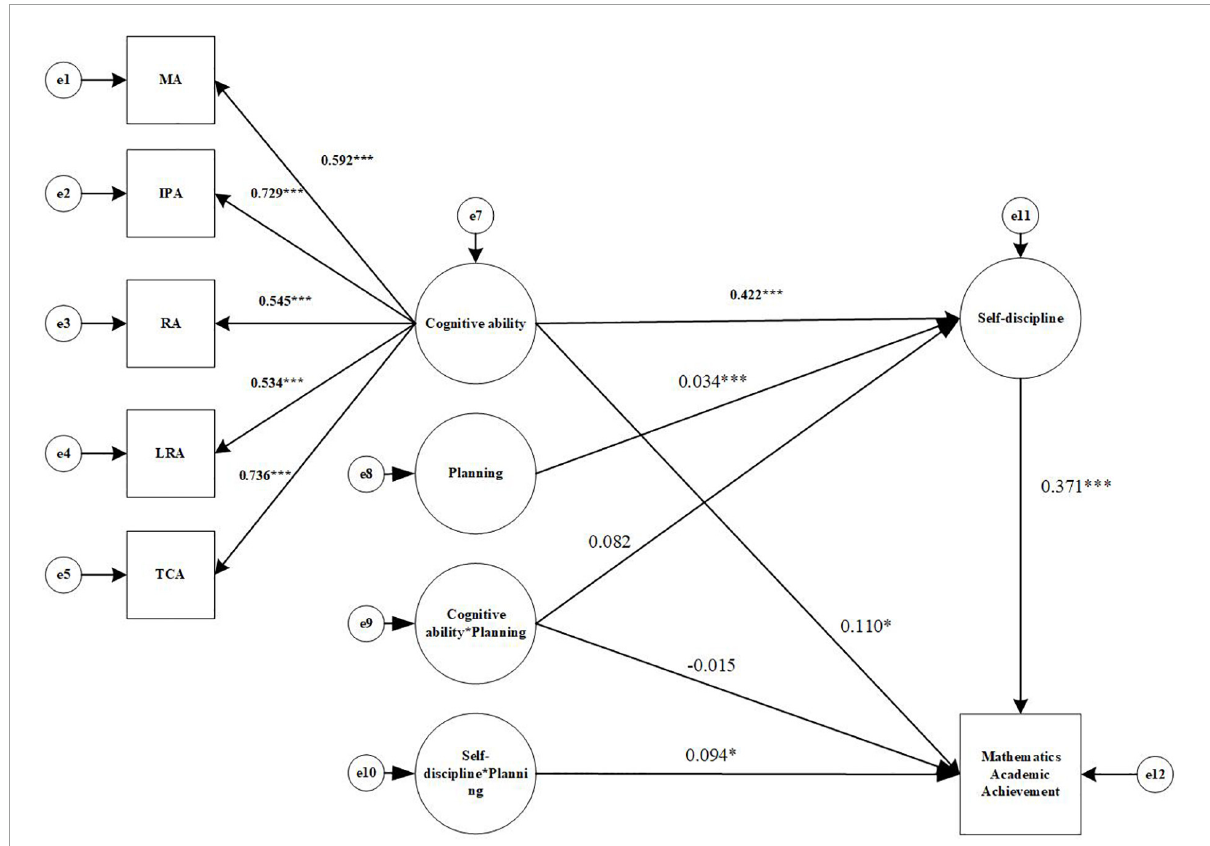
FIGURE5 Structural equation modeling results diagram (Mathematics Academic Achievement). MA, Memory ability; IPA, Information processing ability; RA, Representation ability; LRA, Logical reasoning ability; TCA, Thinking conversion ability. ∗ p < 0.05, ∗∗∗ p <